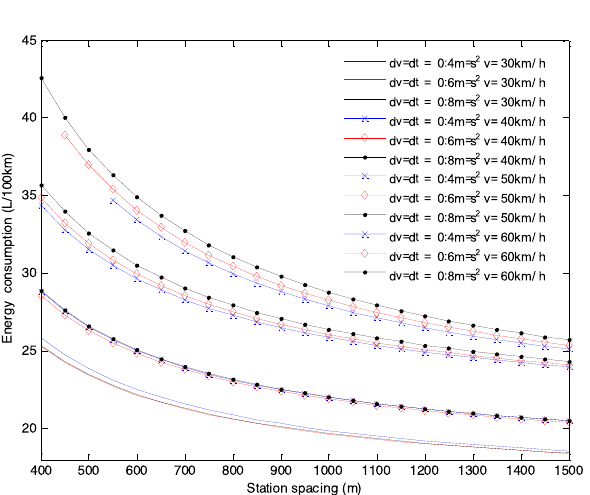
Figure 6. Contrastive analysis of EC under different acceleration strategies, station spacings and maximum